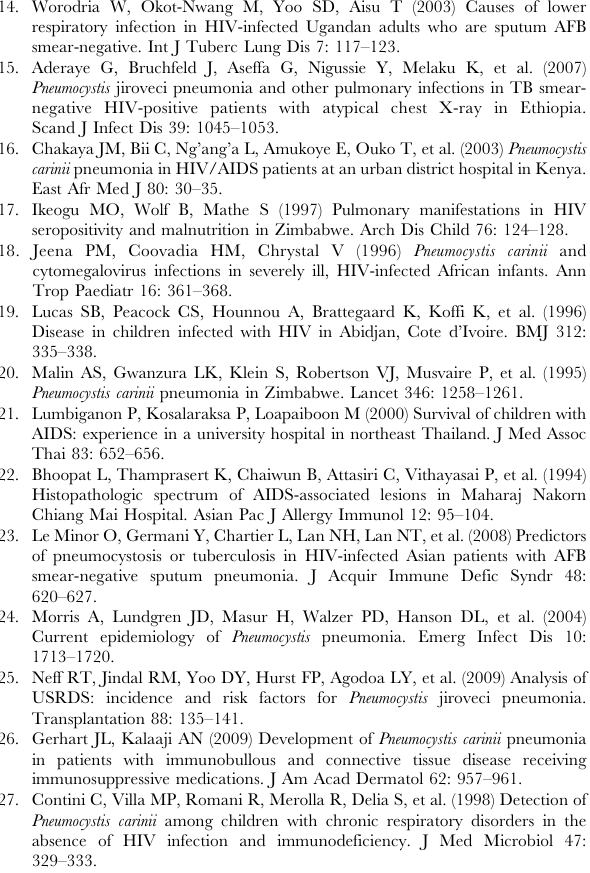
Table S3 Model inputs: cost of treatment, treatment failure rate, and prevalence of disease in the population. Table S4 Sensitivity analysis: cost per life-year gained with variations in diagnostic procedure cost, sensitivity, specificity, treatment failure rates, and treatment costs. *Neither sensitivity nor specificity was increased beyond a value of 1.00. Procedures which in the base model were 0.90 or greater were capped at